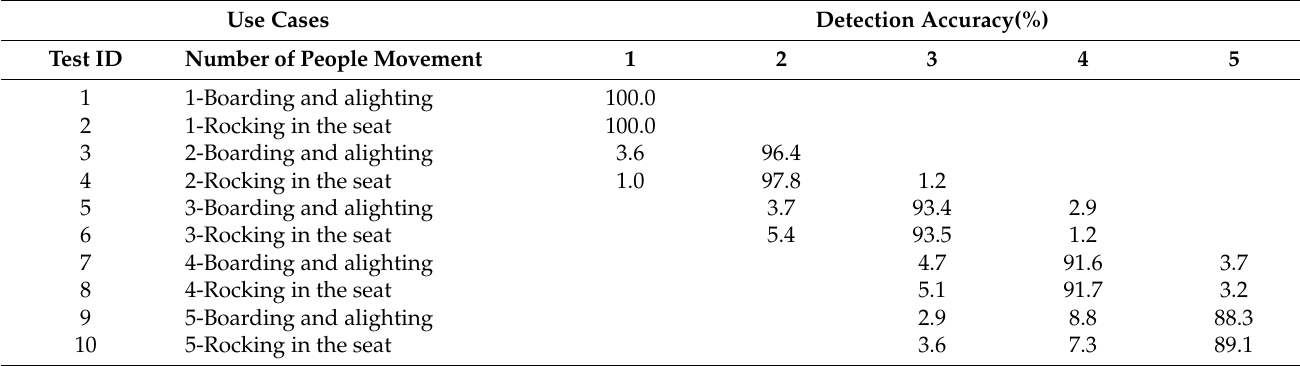
Table 5. Detection results in the dynamic use